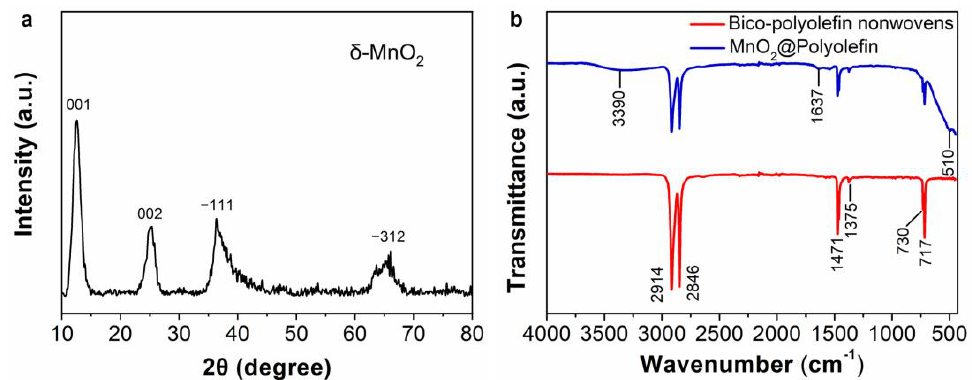
Figure 2. ( a ) XRD pattern of δ -MnO 2 ; ( b ) FTIR spectra of bico-polyolefin spunbond nonwovens and MnO 2 @Polyolefin filter.